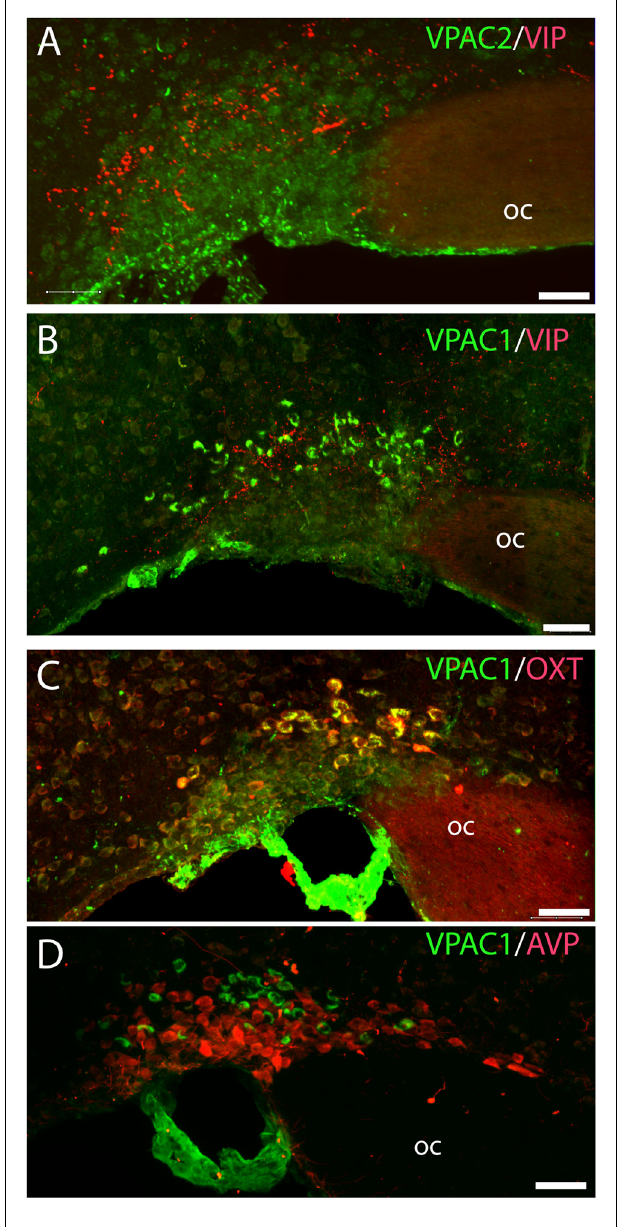
FIGURE 4 | Distribution of VIP (red), VPAC1 (green), VPAC2 (green), OXT (red), and arginine vasopressin (AVP; red) immunoreactivity in the SON. VPAC2 (green) was not visualized in the SON (A) . VIP and VPAC1 immunoreactivity were found in the SON (B) . VPAC1 (green) was also found in the cerebral blood vessel surrounding the SON (C,D) . A Z -stack of high-resolution images used for 3D reconstruction showed colocalization of VPAC1 (green) and OXT (red) visualized as yellow in (C) . AVP and VPAC1 immunoreactivity was found in the SON; 3D reconstruction showed them to be localized in separate neurons. Images (A–D) represent maximal projections of 16 digital sections in a Z -stack ( Z = 2 µ m). Scale bars: (A–D) = 25 µ m.